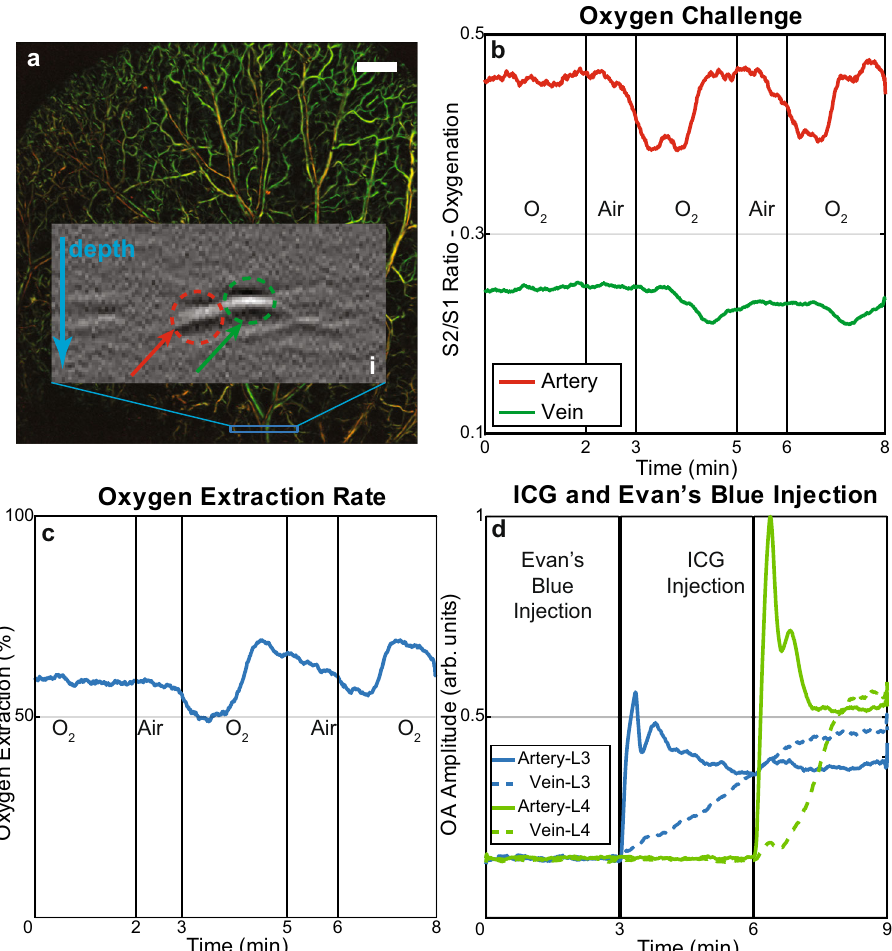
Fig. 4 | In vivo vascular dynamics revealed by FWMOT. Oxygen challenge experiment and dye injection monitoring in the central vein and artery in the mouse ear using FWMOT imaging. a The OA images in the blue wavelengths, showing oxygenated (red) and de-oxygenated (green) vessels. We performed continuously B-Scans on the blue region denoted in a and ‘ i ’ shows such a cross- section. The green arrow and region in ‘ i ’ indicate the selected vein, and the red arrowandregionindicatetheselectedartery.Greenis445nm,redis465nm,scale bar1mm. b ThechangesintheratiobetweentheOAsignalintensityinwavelength